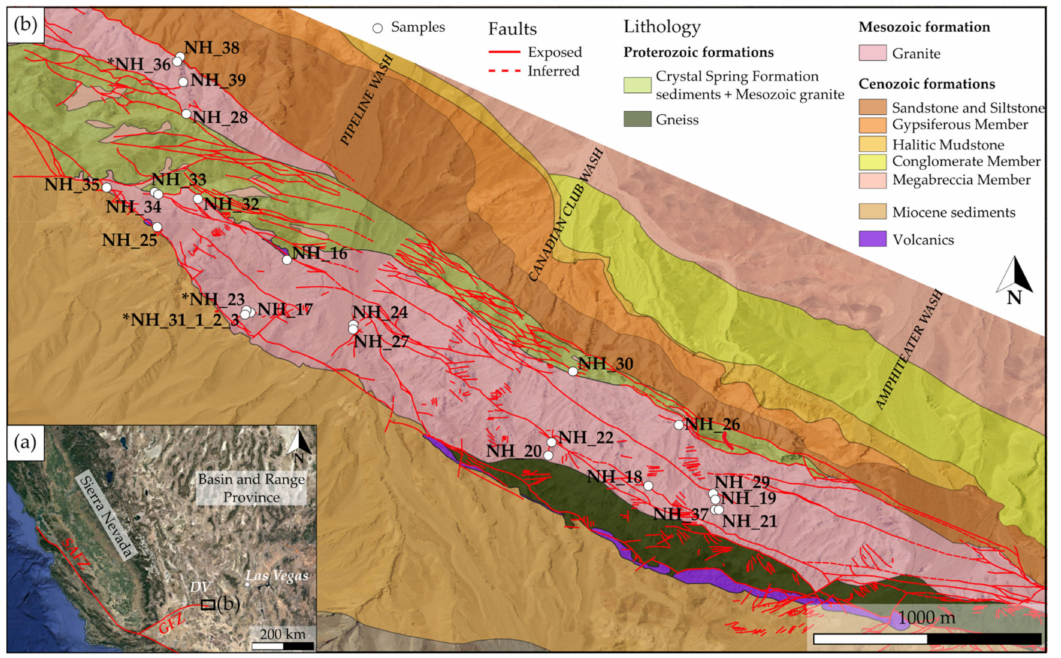
Figure 1. ( a ) Location of the Noble Hills on the western USA satellite map. SAFZ—San Andreas Fault Zone, GFZ—Garlock fault zone, and DV—Death Valley. ( b ) The geological map of the Noble Hills range, modified after [19,38,41]. The quaternary is not displayed, but available on the map provided by [38]. Sample locations are represented by the white dots. The asterisk shows the samples used as case studies in this work. NHF—Noble Hills